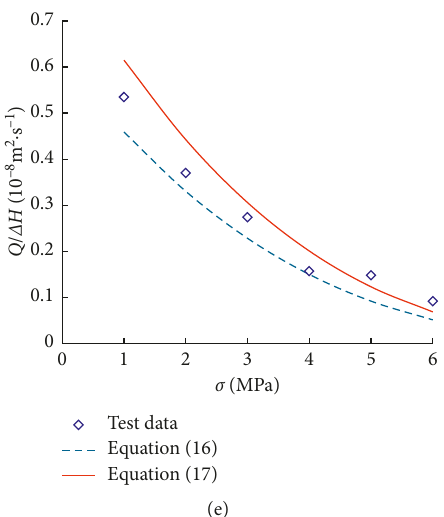
Figure 8: Comparison of the calculated value by using equation (16) and test data. (a) M1. (b) M2. (c) M3. (d) M4. (e) M5.